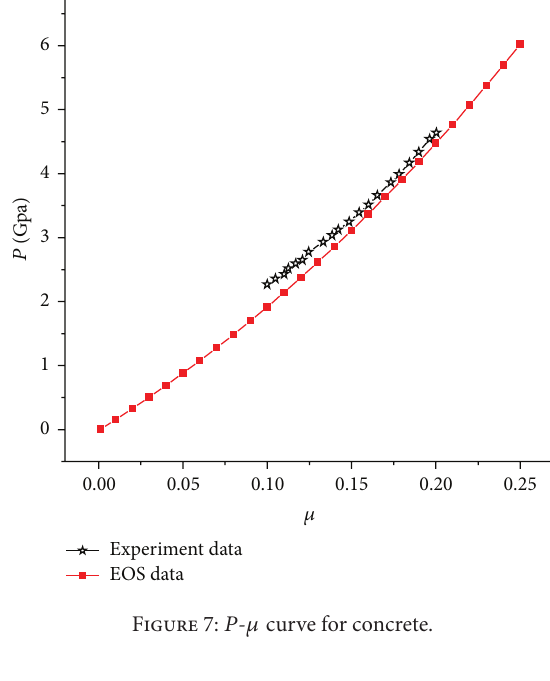
Figure 7: 𝑃 - 𝜇 curve for